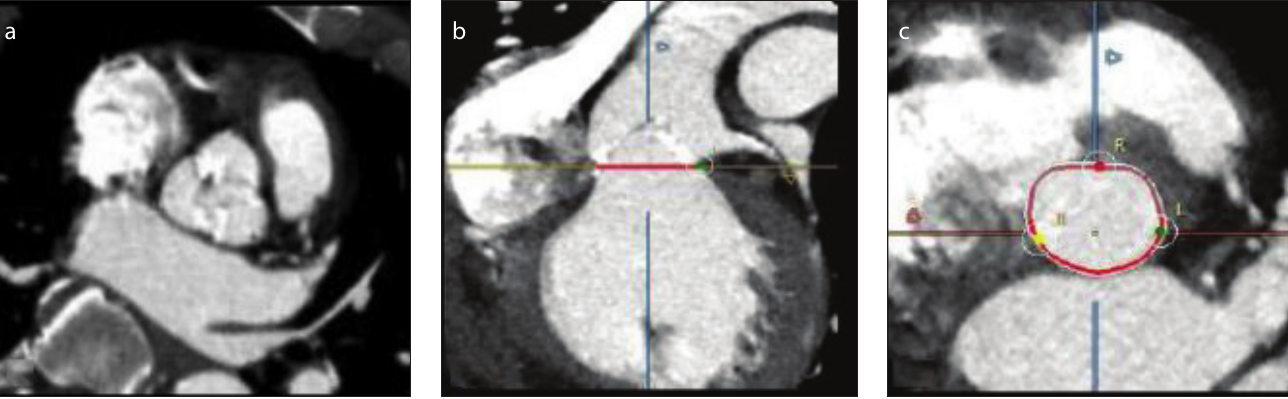
Figure 4. a-c. a, b, c) Evaluation of Aortic Valve (AV) using Circle software (Calgary, AB, Canada): Finding and locating the coronary cusps (red-right, green CoreValve sizing chart. Courtesy of Edwards Lifesciences Cooperation, Irvine, CA.